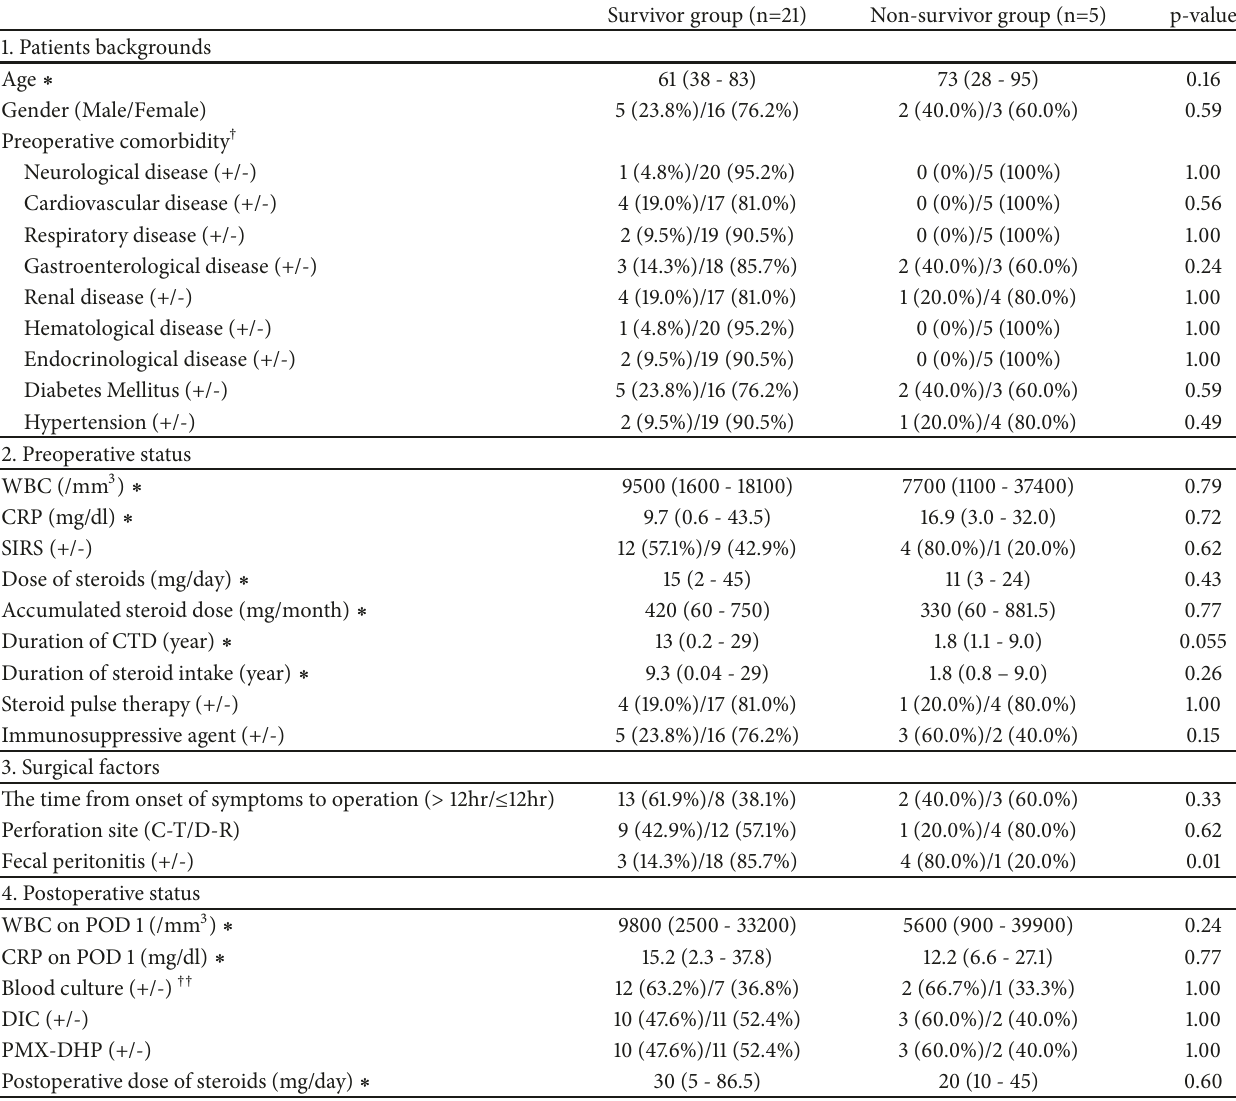
Table 5: Clinicopathological factors in survivors and nonsurvivors among patients with connective tissue disease (CTD).